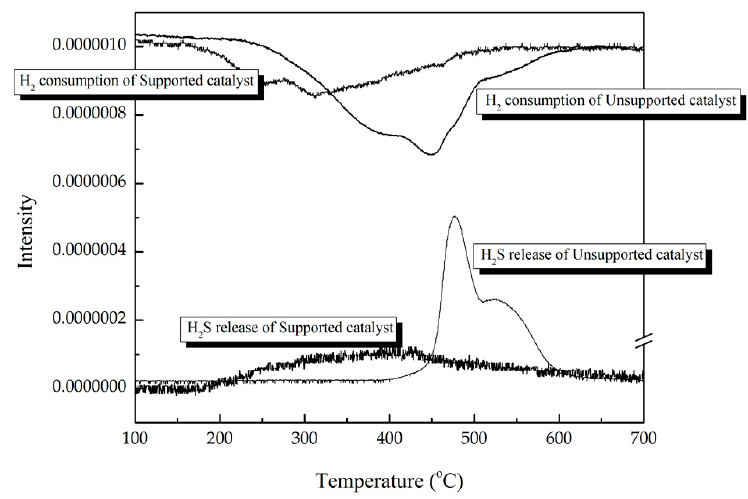
Figure2. Figure 2. Temperature-programmed reduction (TPR) spectra of the supported and unsupported catalyst.